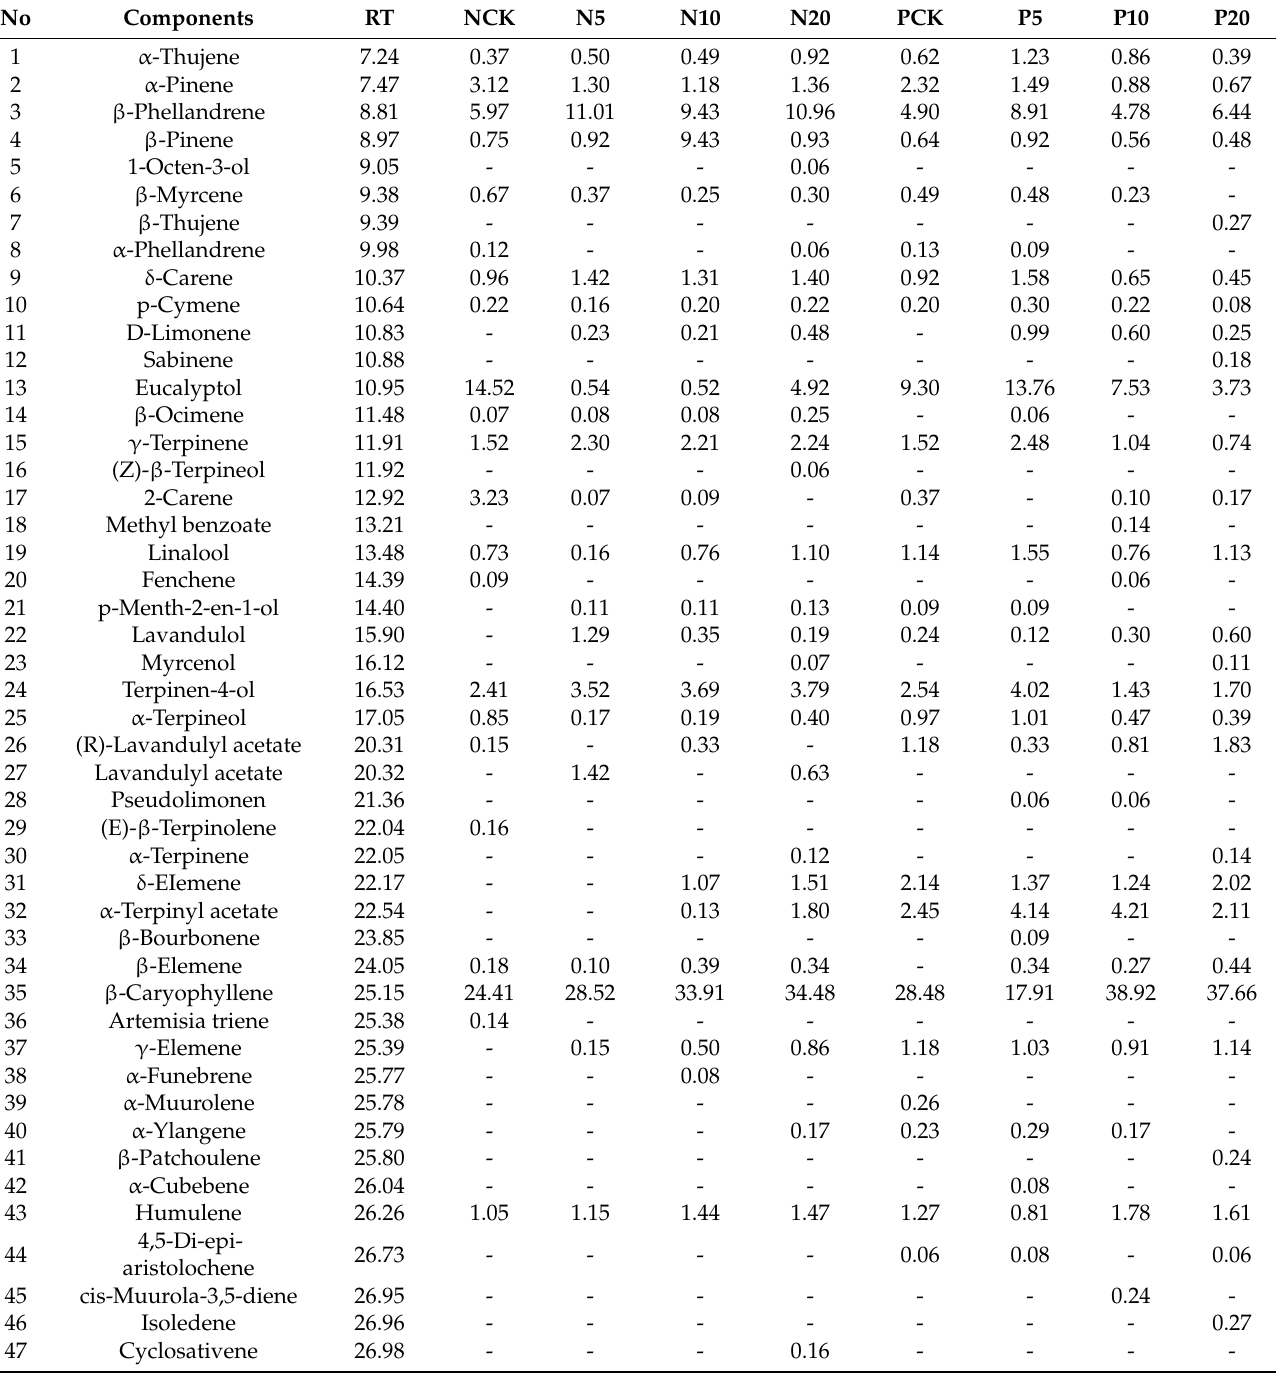
Table 2. Effects of different fertilizer treatments on essential oil components of V. negundo